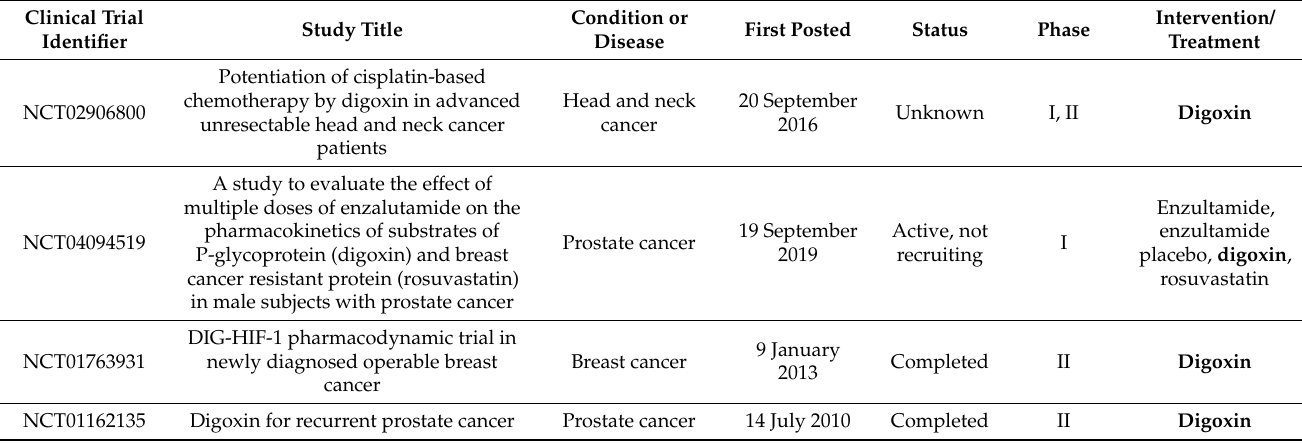
Table 2. Clinical trials of digoxin ( 2 ) for cancer treatment; the data were taken from